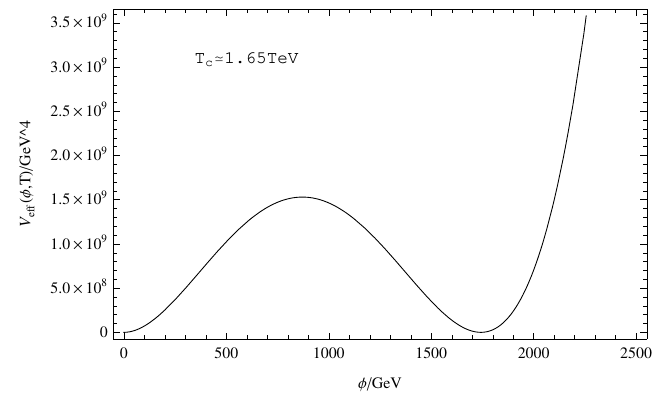
Figure 3 . The finite temperature effective potential V